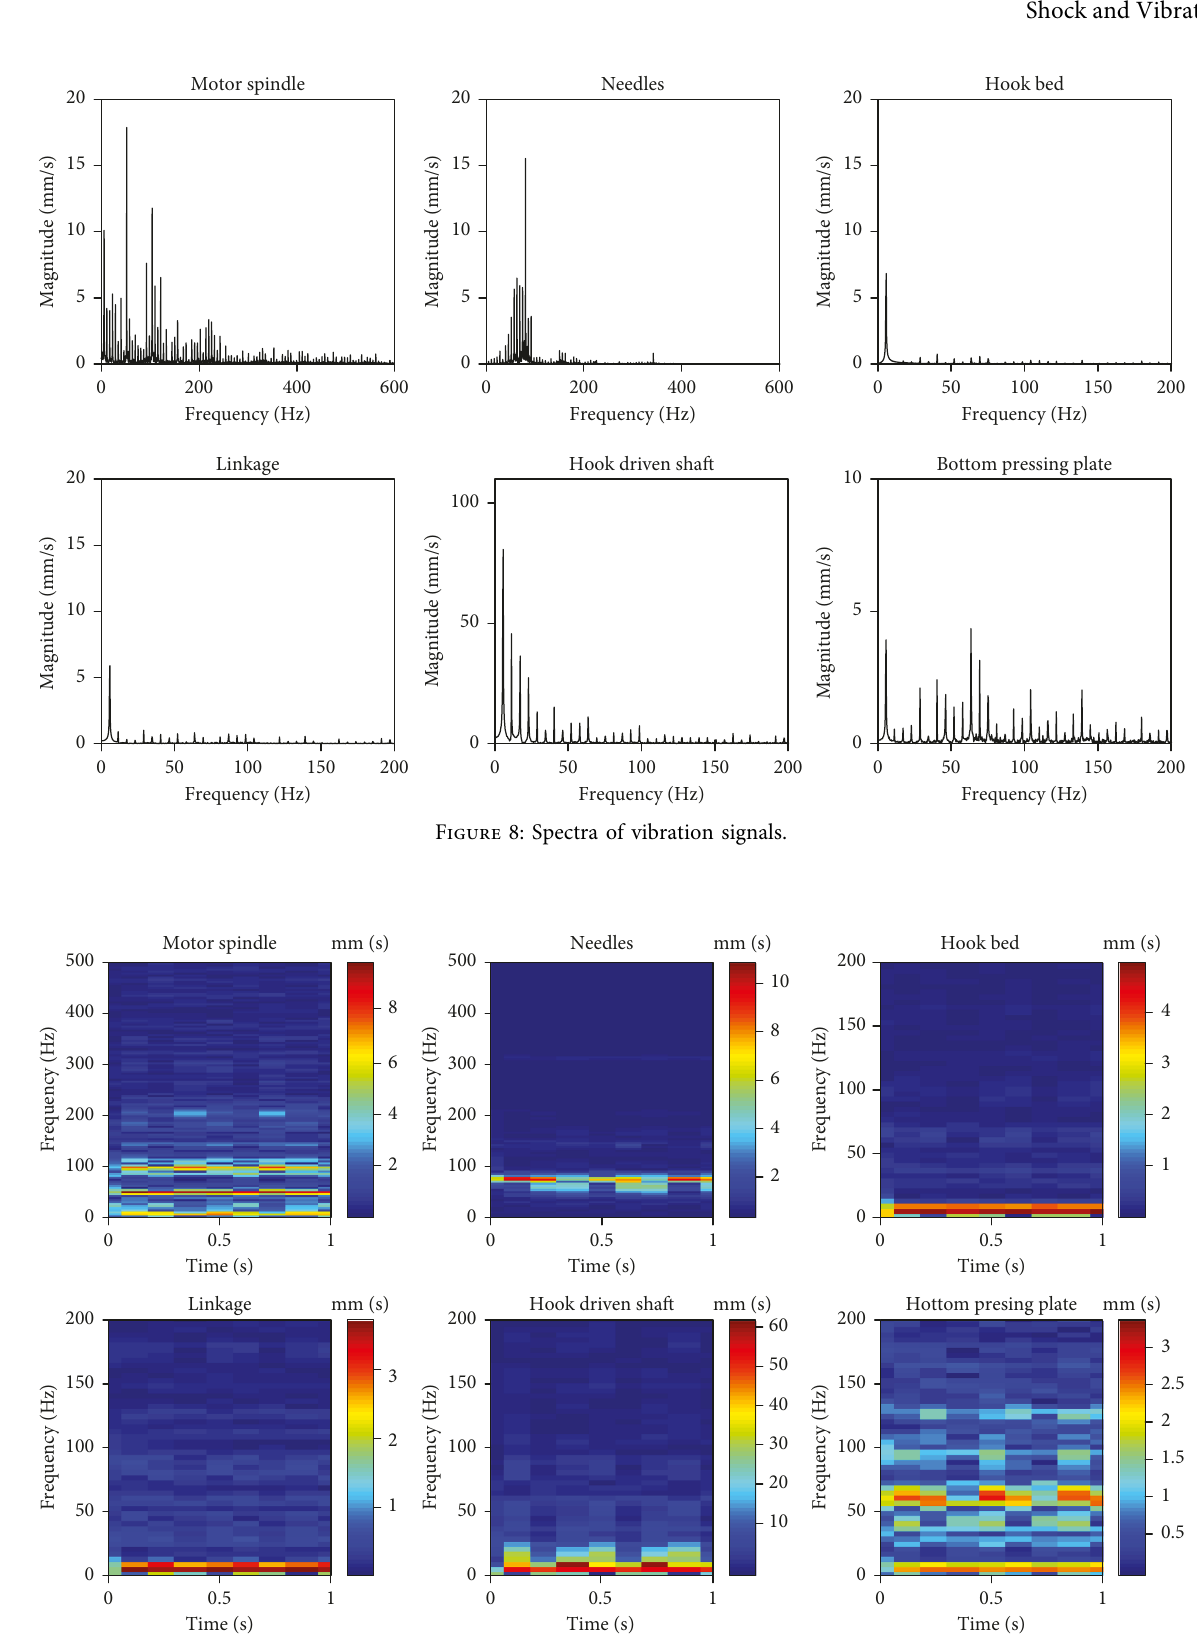
Figure 9: Spectrograms of vibration